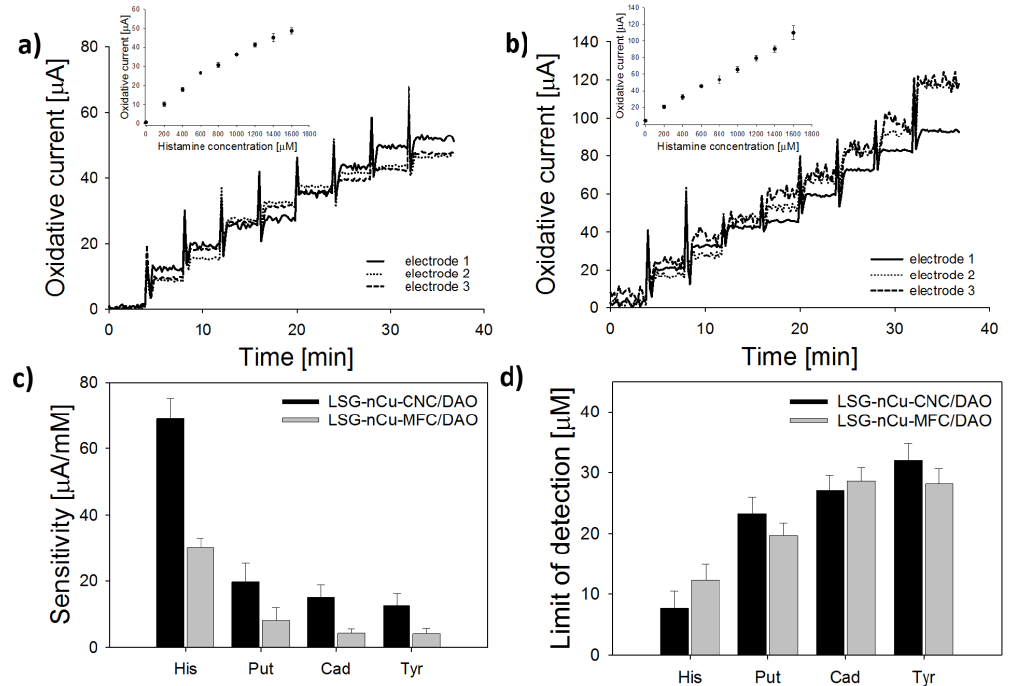
Figure 8. BA calibration for nCu-LSG biosensors prepared with analytical grade materials (LSG-nCu- Figure CNC/DAO) or locally sourced materials (LSC-nCu-MFC/DAO). Representative DCPA time series during stepwise addition of histamine (His) for ( a ) DAO-CNC and ( b ) MFC-DAO biosensors. Average ( c ) sensitivity and ( d ) limit of detection toward various BA. Error bars represent the standard deviation of the arithmetic mean ( n = 3 sensors).